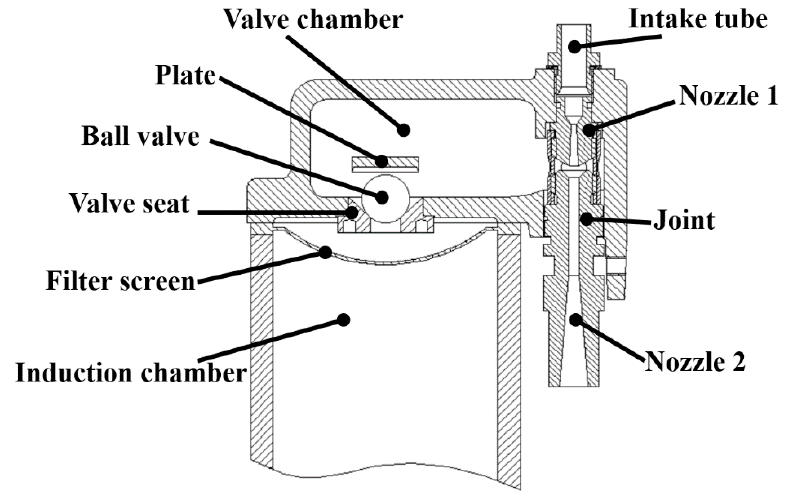
Figure 2. Structure of the self-priming system.